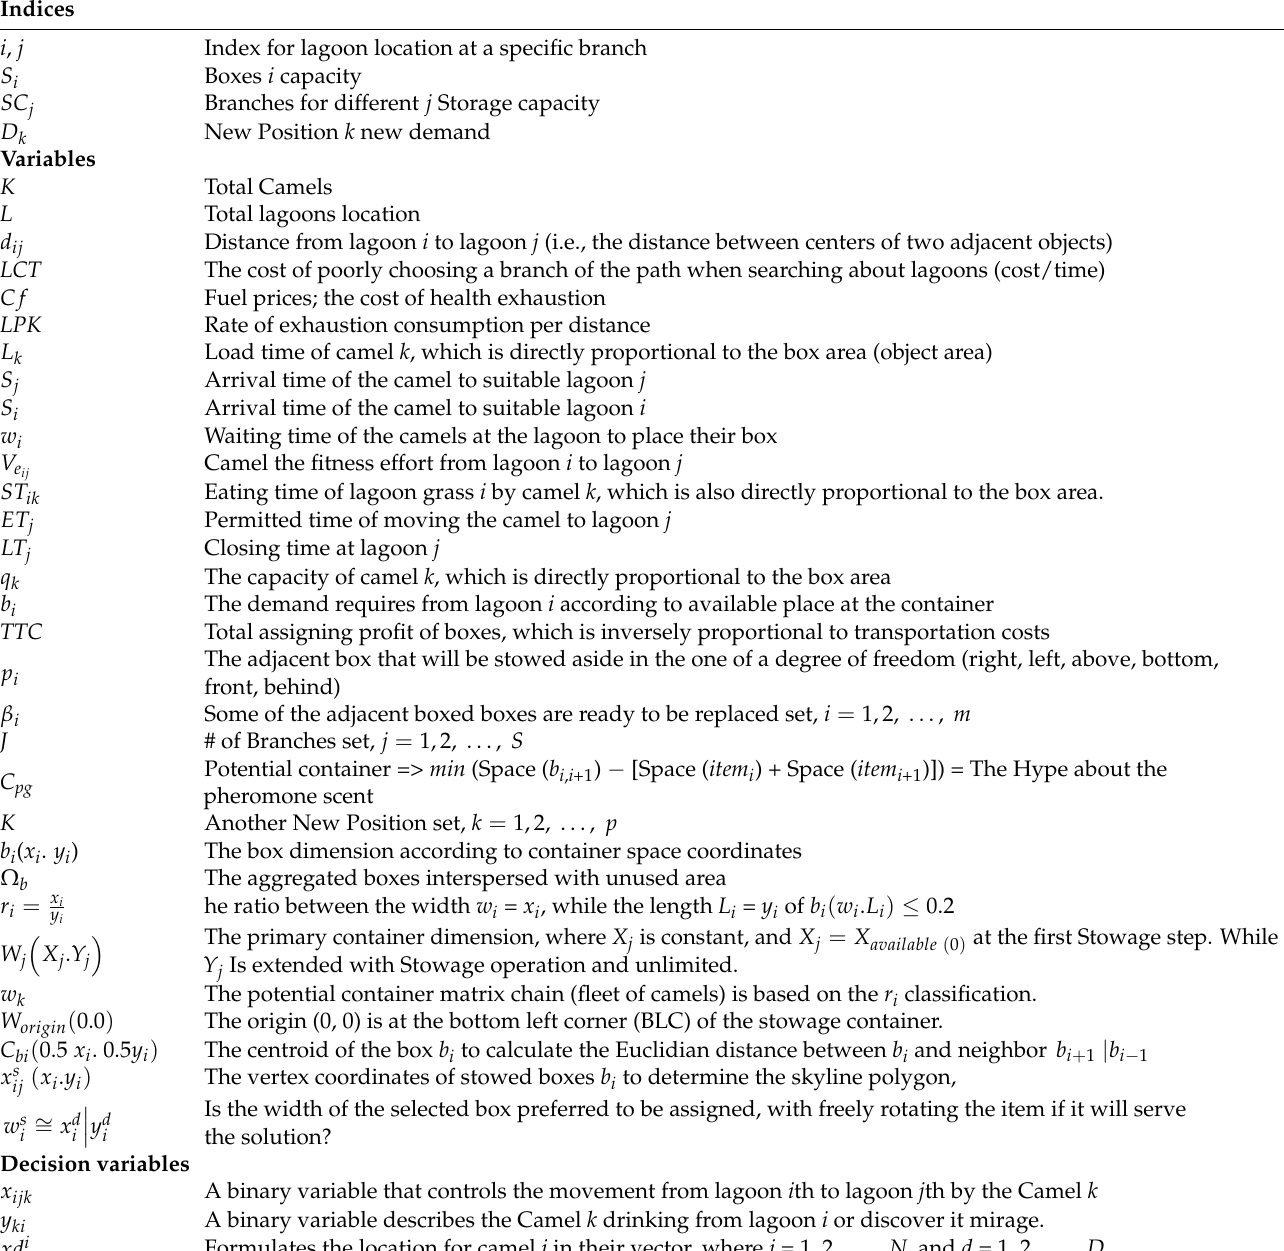
Table 2. The Parameters of OSM-CA algorithm